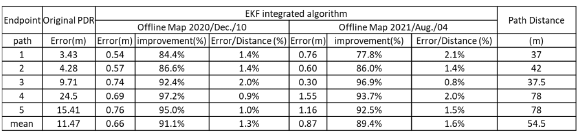
Table 1. The error of the end of trajectory result 2020/Dec./10